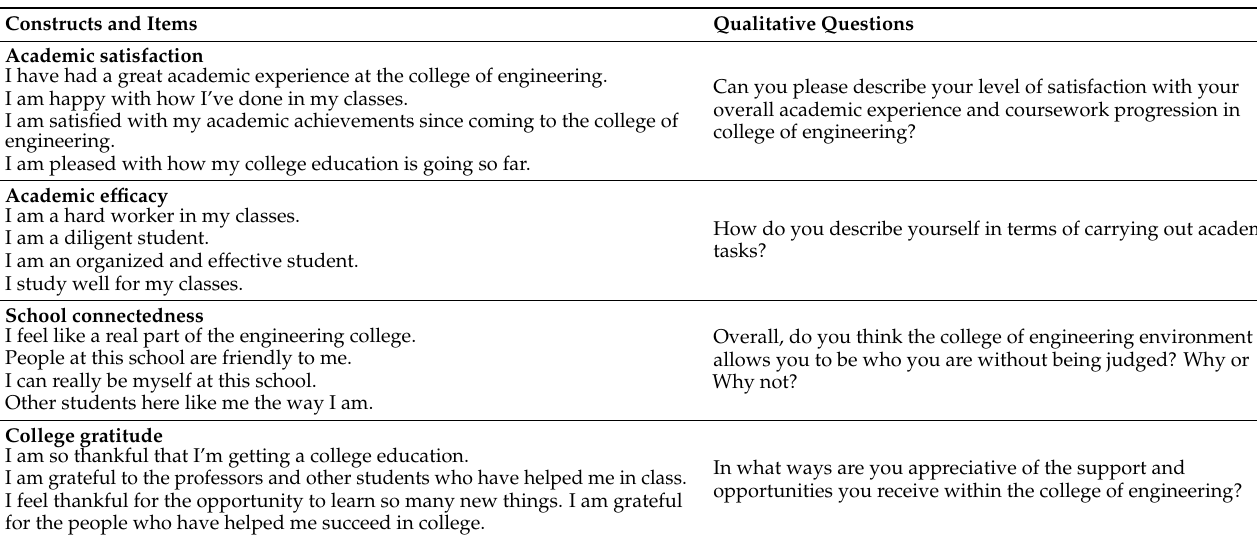
Table A1. College student subjective wellbeing questionnaire (CSSWQ) items and their corresponding study interview questions in four